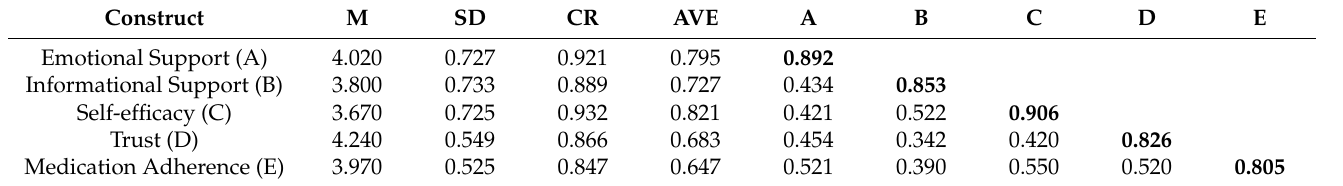
Table 3. Reliability and